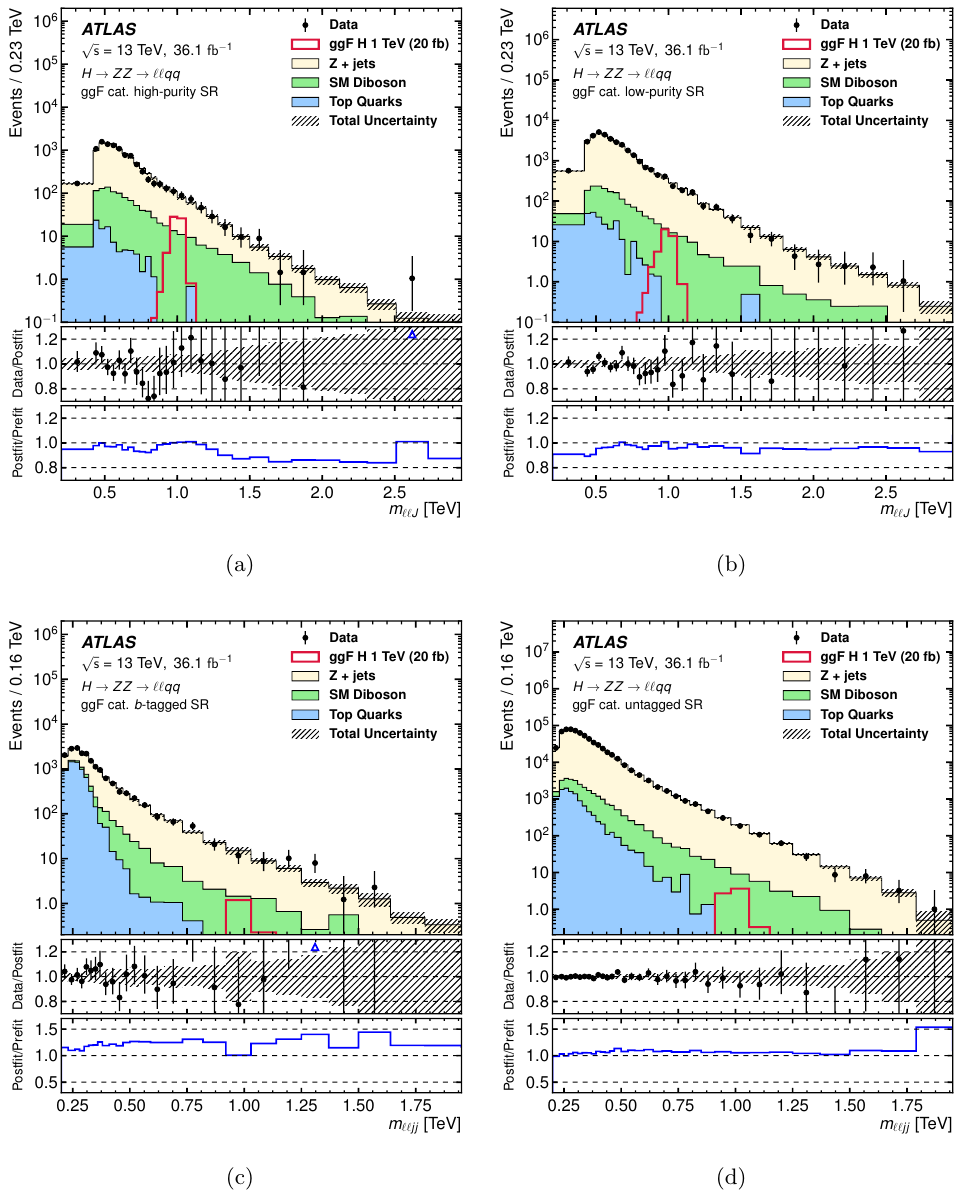
Figure 8 . Comparisons of the observed data and expected background distributions of the (cid:12)nal discriminants of the ggF category for the H ZZ ‘‘qq search: m ‘‘J of (a) high-purity ! ! and (b) low-purity signal regions; m ‘‘jj of (c) b -tagged and (d) untagged signal regions. For illustration, expected distributions from the ggF production of a 1 TeV Higgs boson with (cid:27) ( H (cid:2)B ! ZZ ) = 20 fb are also shown. The middle panes show the ratios of the observed data to the background predictions. The uncertainty in the total background prediction, shown as bands, combines statistical and systematic contributions. The blue triangles in the middle panes indicate bins where the ratio is nonzero and outside the vertical range of the plot. The bottom panes show the ratios of the post-(cid:12)t and pre-(cid:12)t background predictions.